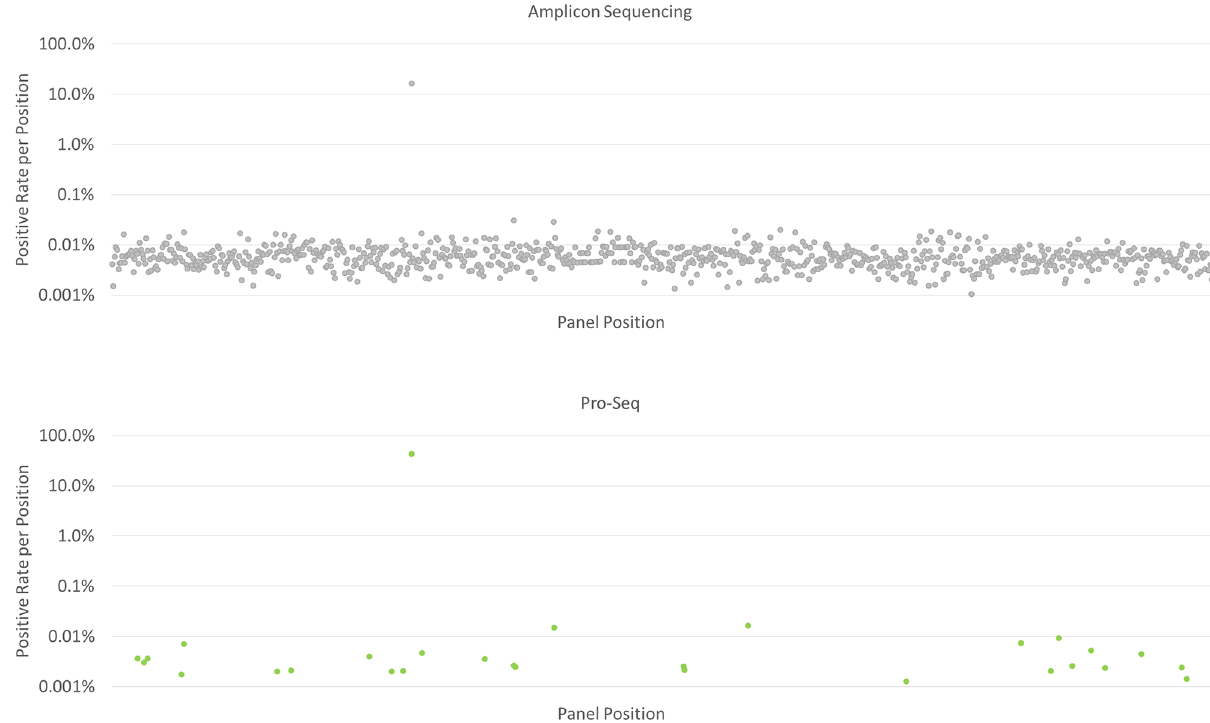
Fig 5. Comparative sequencing performance between amplicon sequencing with high fidelity polymerase (top) and Pro-Seq (bottom). A wild-type plasma sample was sequenced using a 19-amplicon panel with both methods, and the FPR plotted per base position. Amplicon sequencing (grey) has an average FPR of 1.2 x 10 −4 errors per base, compared to Pro-Seq (green), which had an average FPR of 1.1 x 10 −6 errors per base (a known SNP at panel position 237 is ignored for FPR calculations).